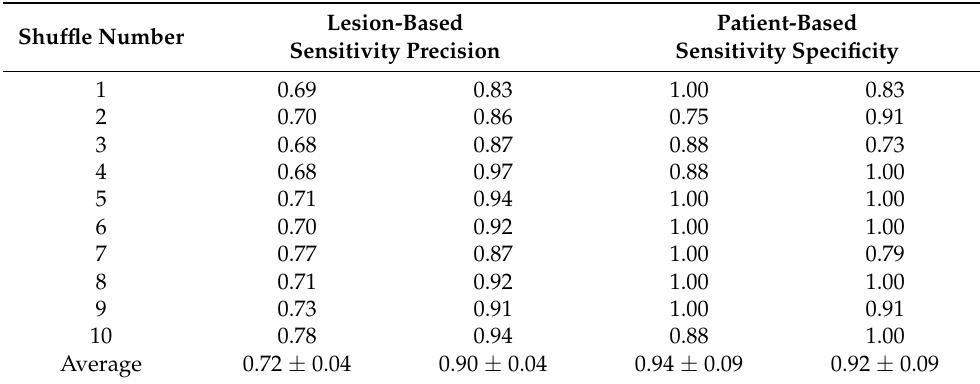
Table 2. The quantitative results of the YOLO v4. All 194 prostate cancer (PC) bone scintigraphy (BS) images were shuffled 10 times. One shuffle means one cross-validation.